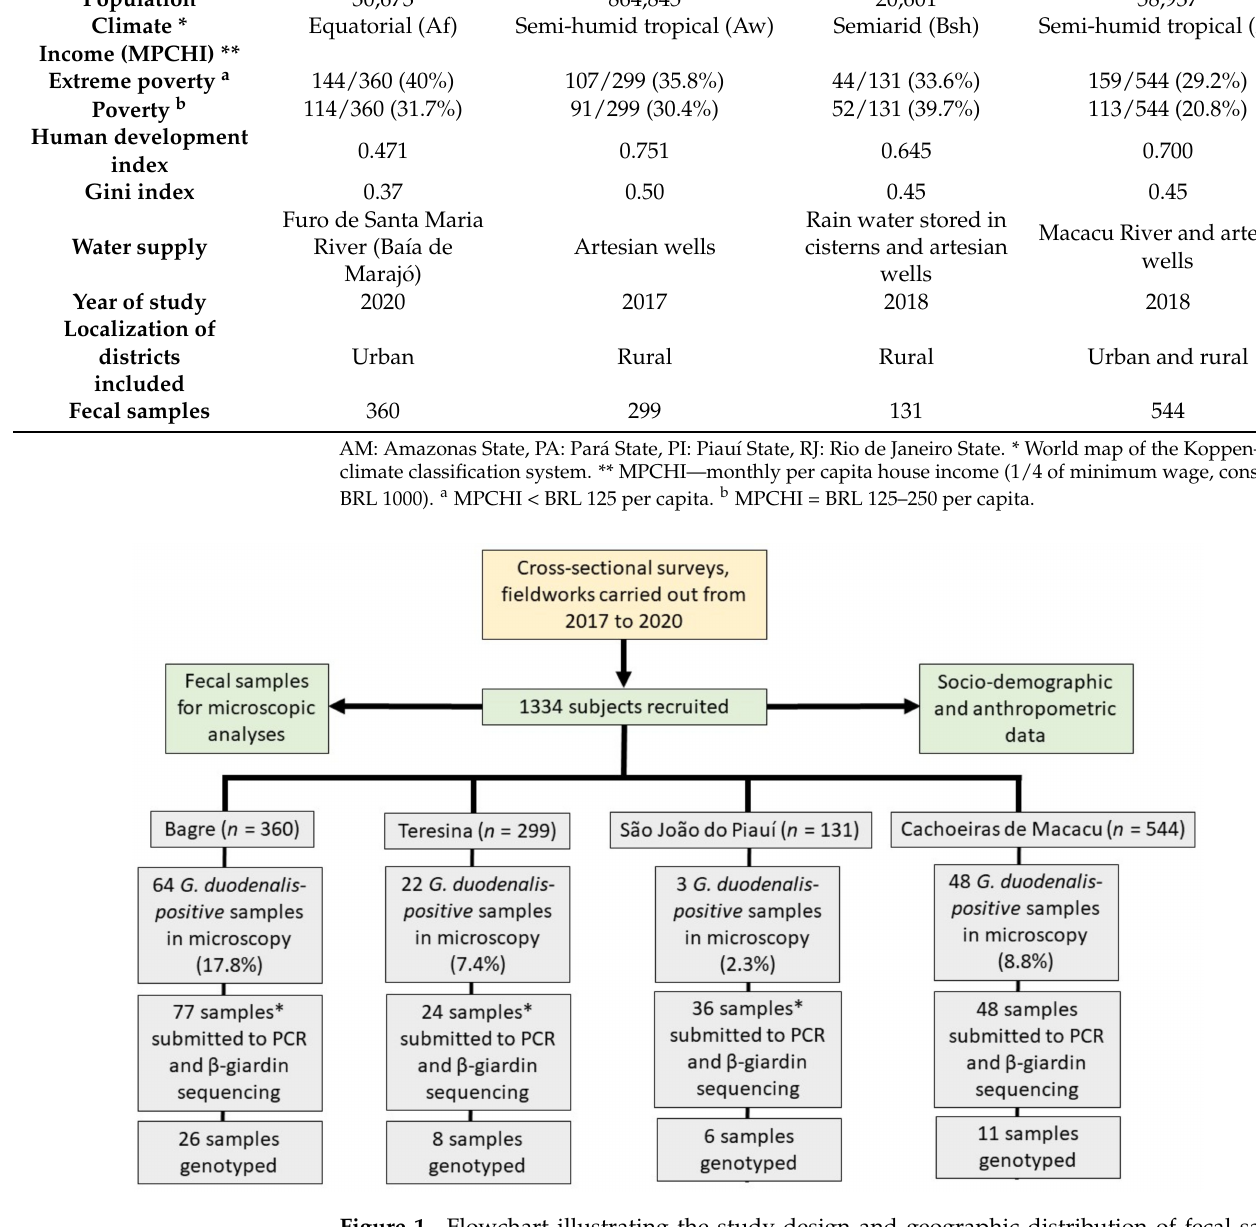
Figure 1. Flowchart illustrating the study design and geographic distribution of fecal samples analyzed, including those positive for Giardia duodenalis and those that could be genotyped by partial sequencing of the giardin beta gene. * Includes negative samples on microscopy, randomly or when another individual from the same household was positive with the following distribution: 7 in Bagre, 2 in Teresina and 33 in S ã o Jo ã o do Piau í